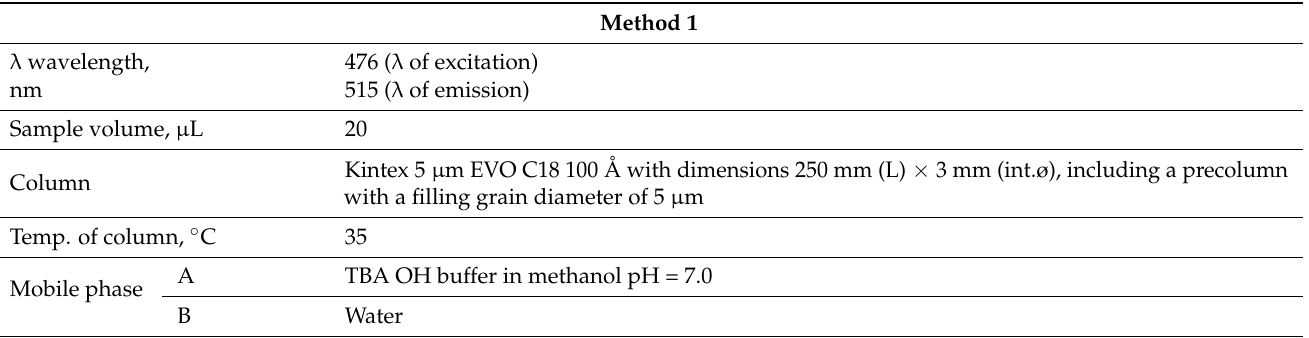
Table 3. Chromatographic analysis parameters used during optimization for Method 1, Method 2 and Method 3. Method